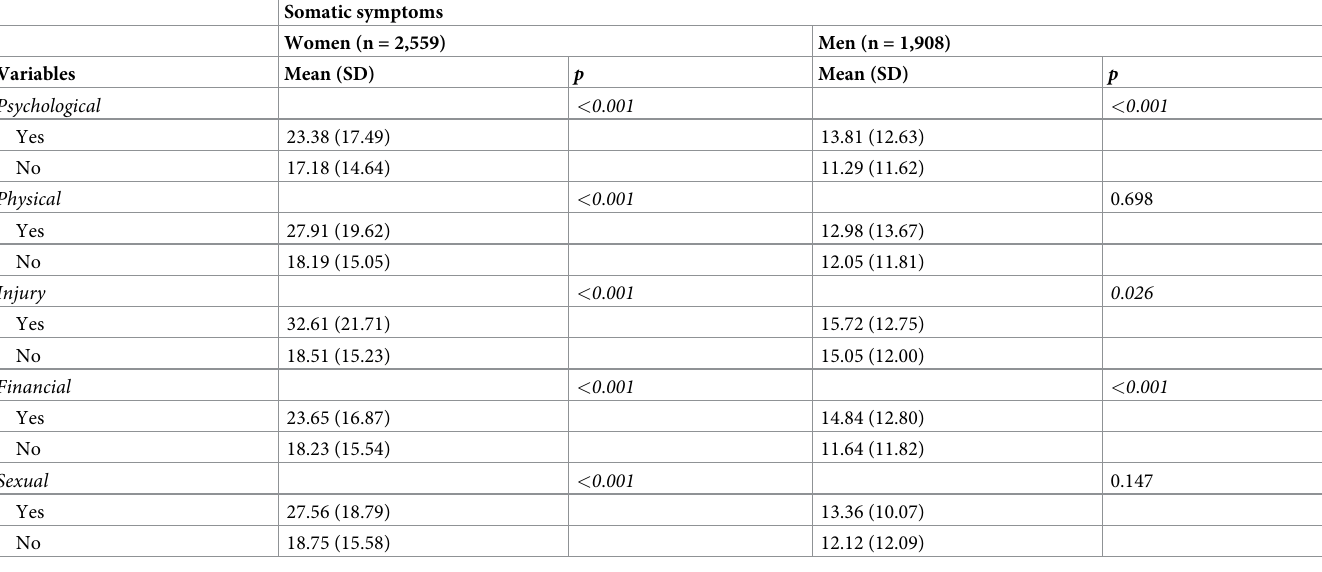
Table 2. Lifetime abuse associated with somatic symptoms among women and men. Somatic